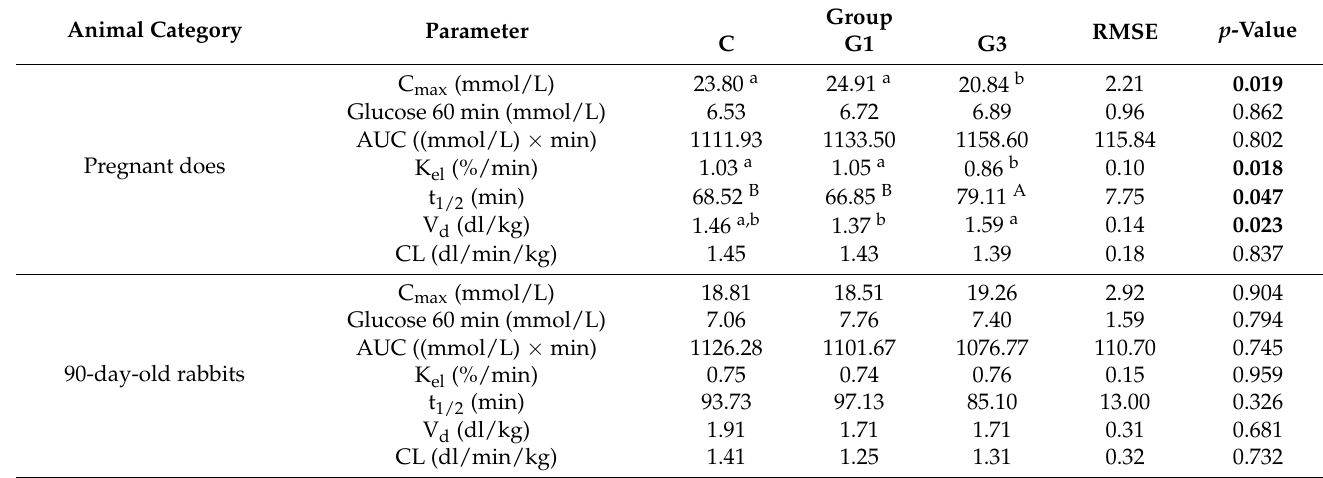
Table 3. Intravenous glucose tolerance test-derived indices obtained in pregnant does and 90-day-old rabbits of control group (C, n = 7/category) and groups with 1% (G1, n = 7/category) and 3% (G3, n = 7/category) of Goji